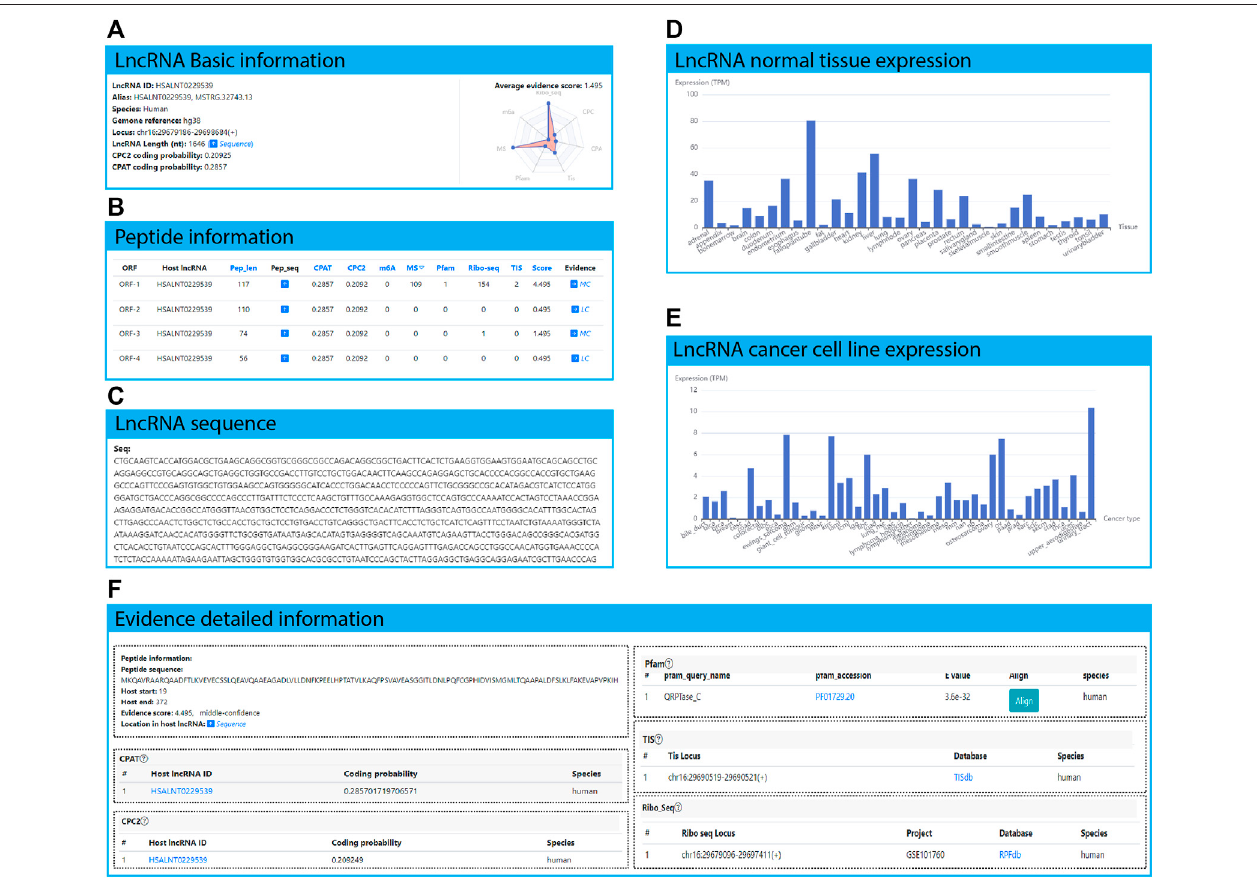
FIGURE 4 | HSALNT0275775 as an example application of the LncPep database. (A) Basic information of lncRNA HSALNT0275775, including lncRNA ID, alias, species,genomereference,genomiclocus,andlength. (B) ThesummarizedtableofORFandpeptideinformationoflncRNAHSALNT0275775. (C) TheRNAsequence and length of lncRNA HSALNT0275775 shown in the popup window by clicking the “ sequence ” arrow in (A) . (D) The expression levels of lncRNA HSALNT0275775 across32differentnormalhumantissues. (E) TheexpressionlevelsoflncRNAHSALNT0275775 across44differenthumancancercelllines. (F) Detailedevidence of the selected peptide of lncRNA